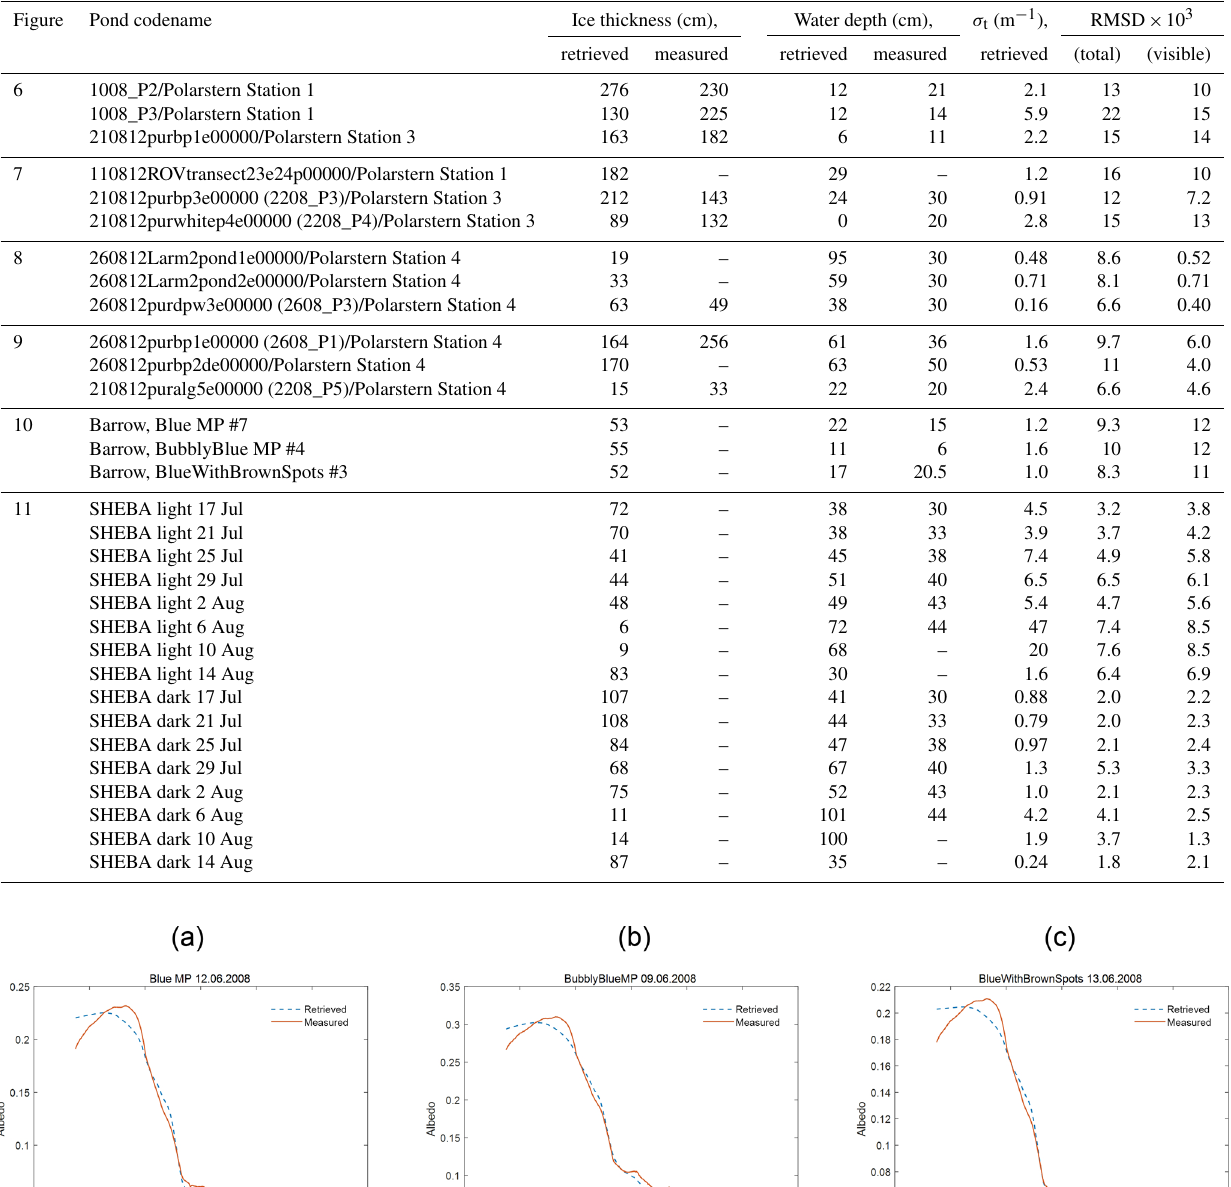
Table 2. Measure and retrieved pond parameters derived from the spectral range 0.35 to 1.3µm (total). RMSD values between measured and modeled spectra are given for the complete spectral range and the visible part ( λ < 0 . 73µm).